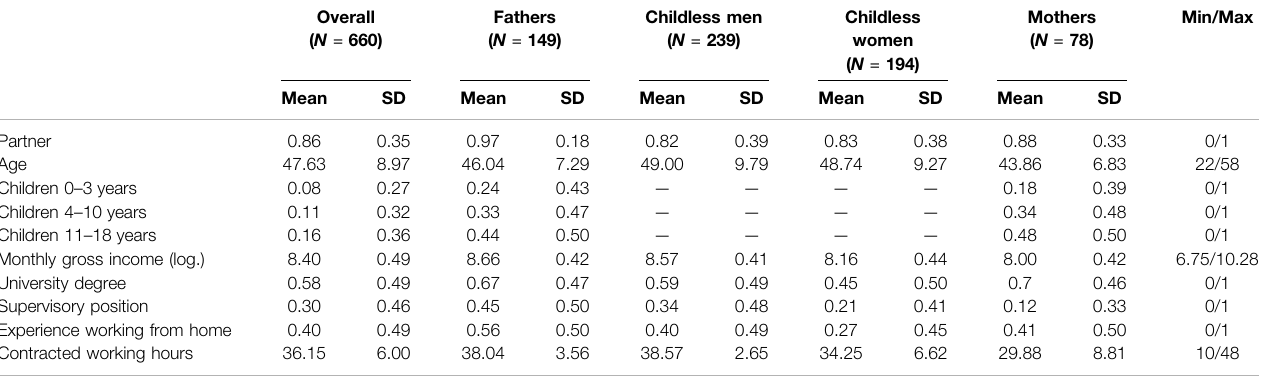
TABLE 2 | Descriptive statistics control variables.